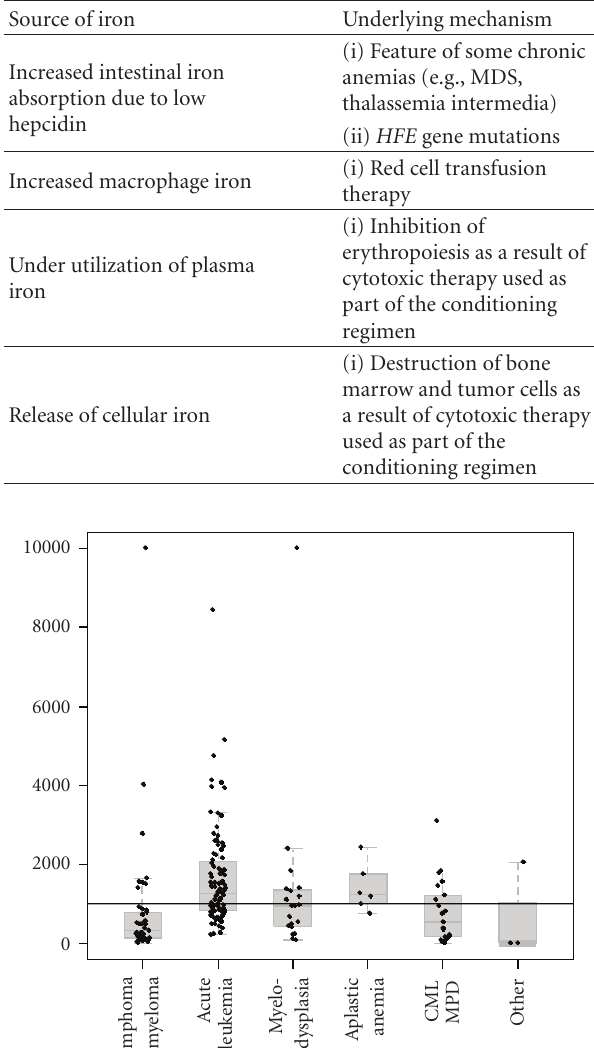
Table 1: Causes of increased NTBI in HSCT recipients.